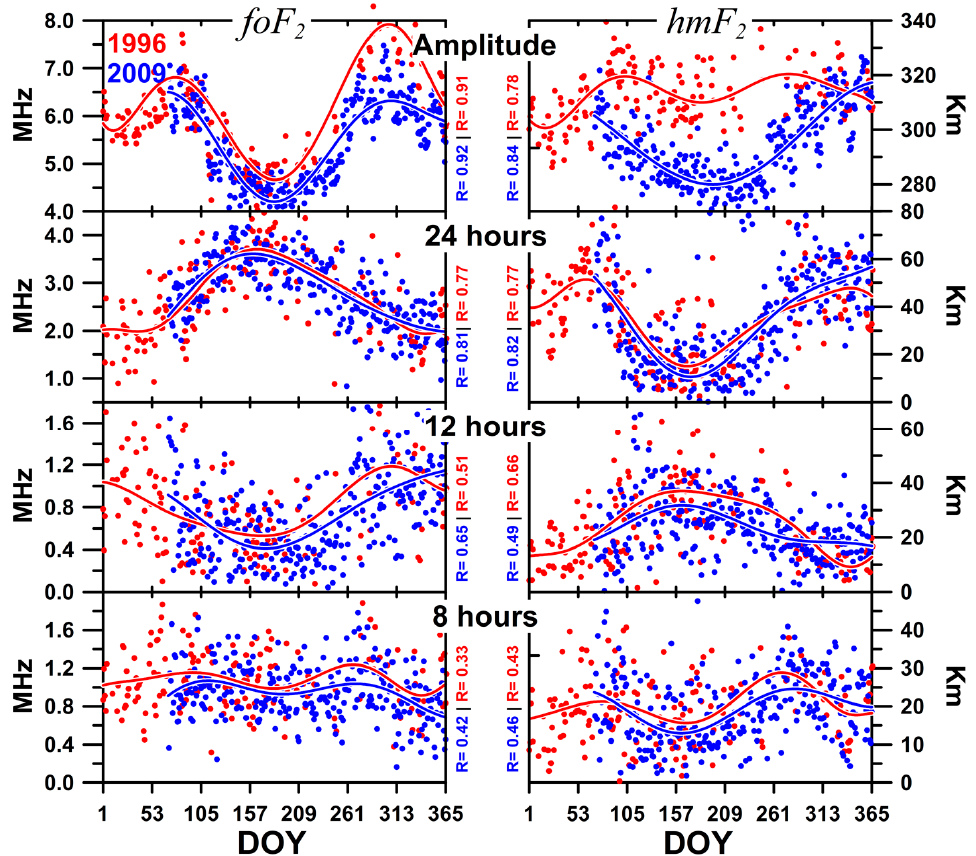
Figure 5. Variability of the amplitude, diurnal (m = 1; 24 h), semidiurnal (m = 2; 12 h), and terdiurnal components (m = 3; 8 h) (from top to bottom) of the foF 2 and the hmF 2 parameters (left and right columns, respectively). The dots are the data, while the continuous lines represent the sixth-order polynomial approximation of them. The correlation coefficient R between the data and polynomial fitting is also shown. Red and blue for 1996 and 2009, respectively.